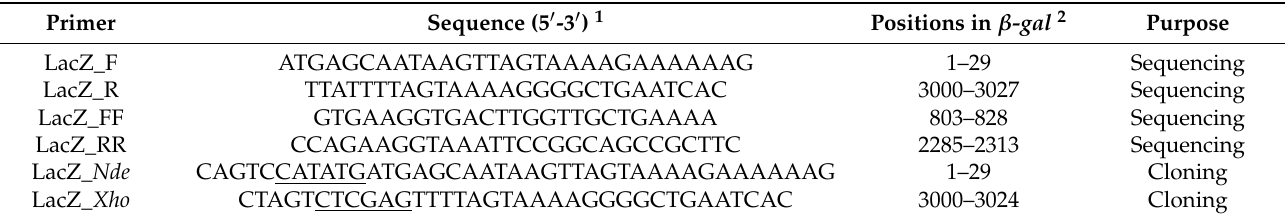
Table 2. Primers used in this